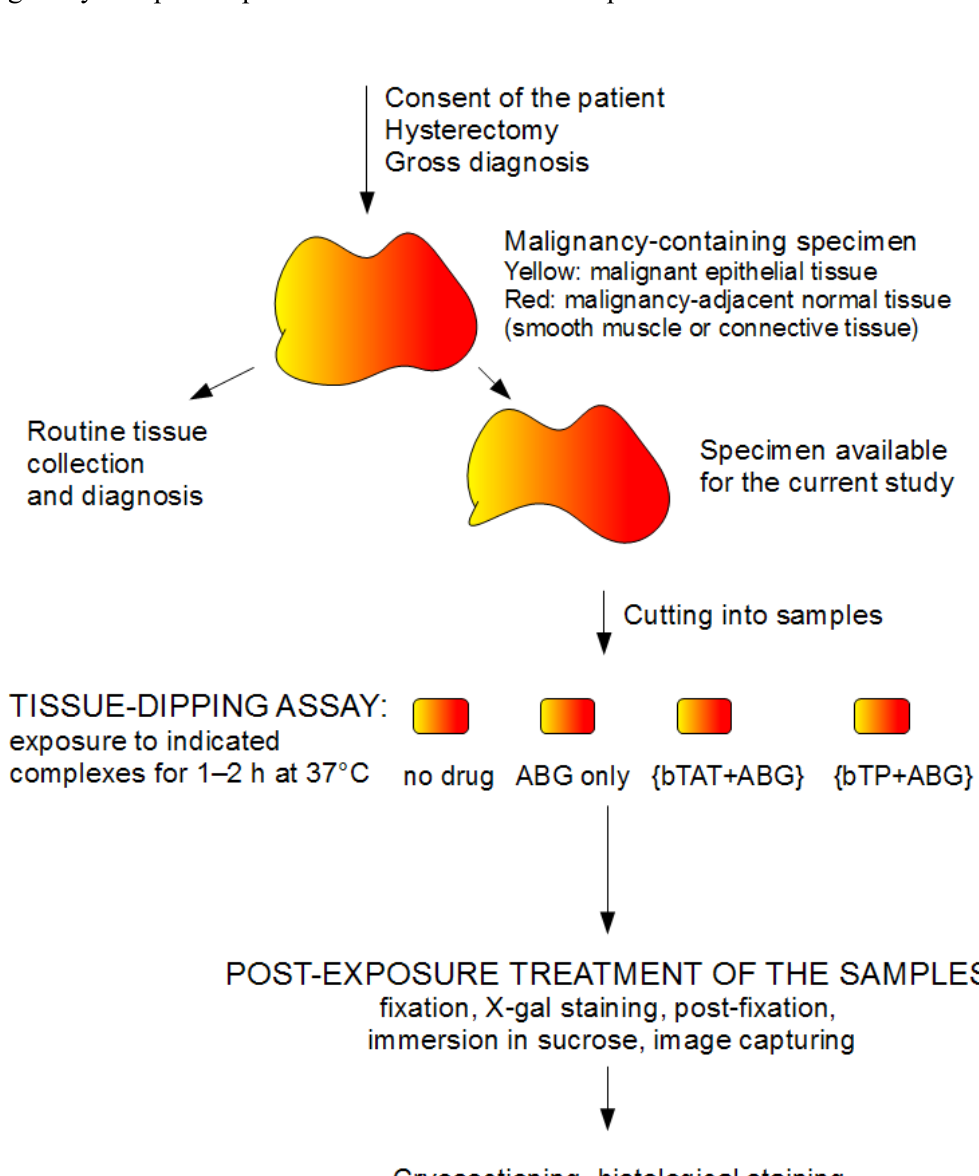
Figure 1. Schematic overview of the experimental setup: specimen processing, tissue- dipping assay and post-exposure treatment of tissue